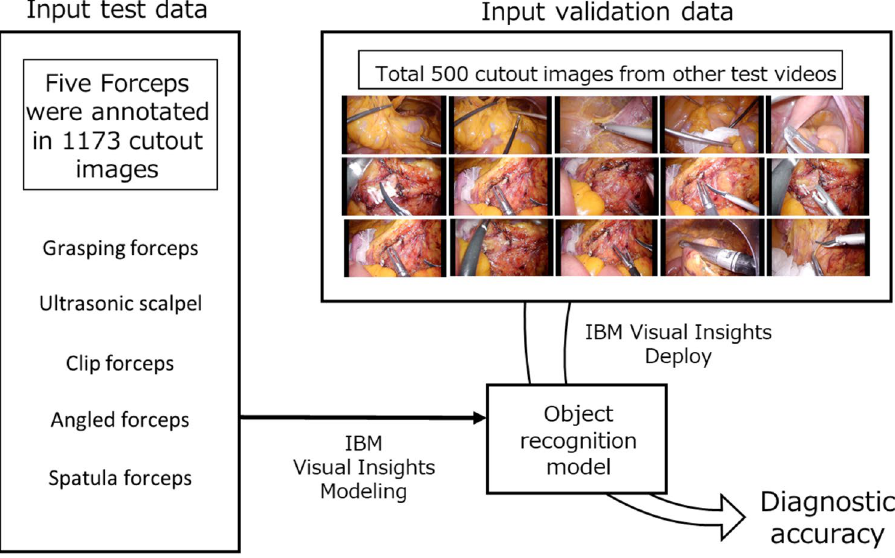
Figure 3. Flow of analysis using IBM Visual Insights. The five selected types of forceps were labeled in 1173 extracted images to create a forceps-type recognition model. Another 500 cutout images used for validation were input in the model to verify whether each type of forceps was recognized